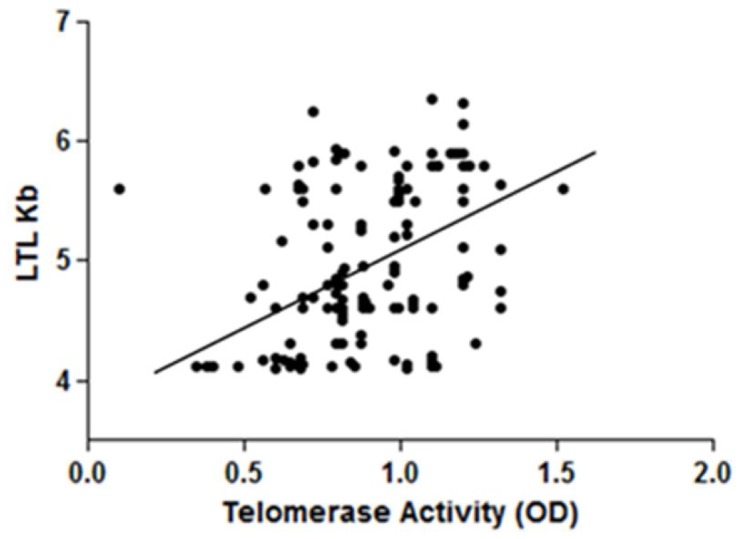
Correlation between LTL and telomerase activity in all population study.Partial correlations (r = 0.208; p = 0.002) between Leukocyte Telomere Length (LTL) and PBMC telomerase activity in all study population (n = 217), adjusted by gender, age and smoking habit.